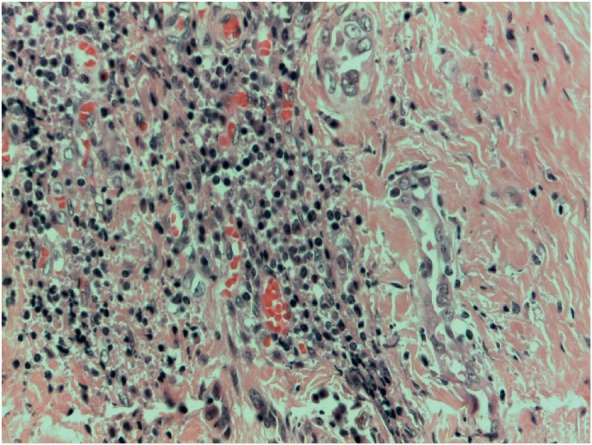
Papillary carcinoma sclerosing variant x400 magnification.